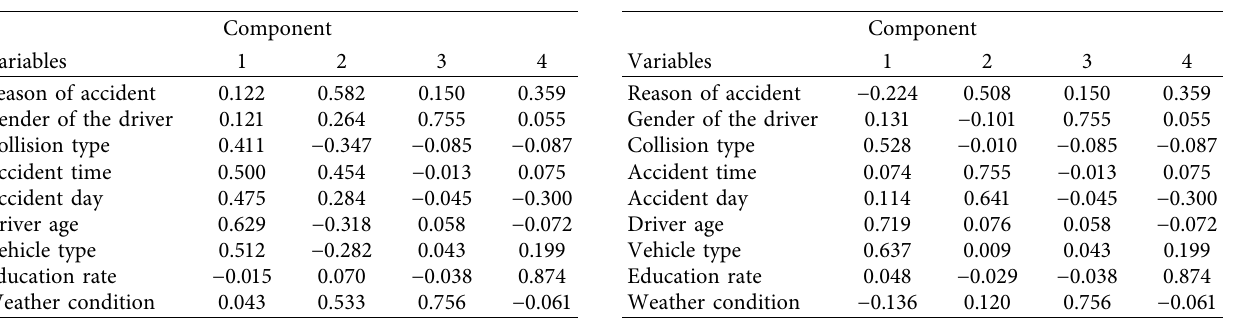
Table 7: Component matrix before rotation. Table 8: Rotated component